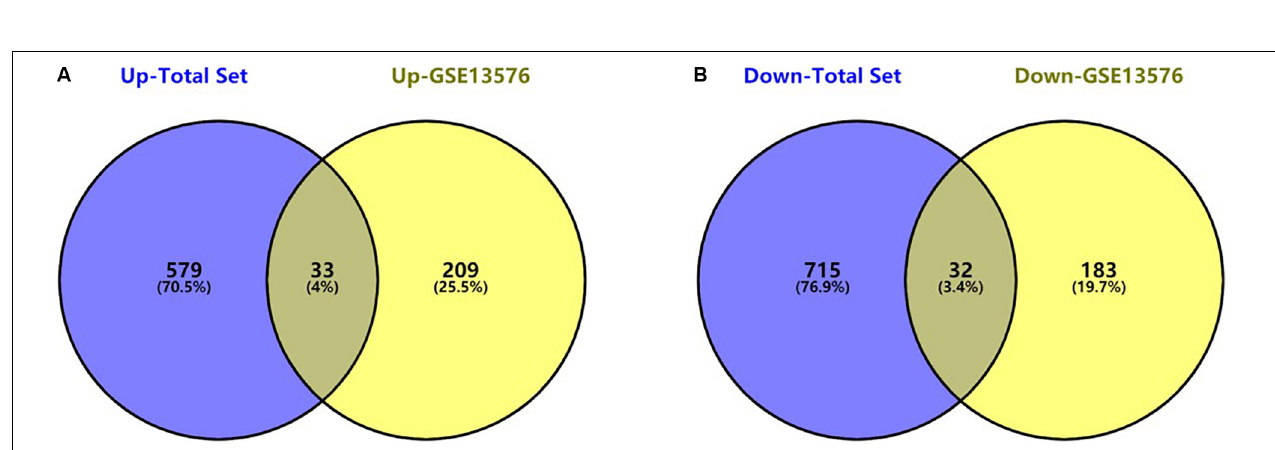
FIGURE 3 | Commonly changed DEGs in Total Set and GSE13576. (A) Upregulated genes in two datasets (33 common DEGs) (B) Downregulated genes in two datasets (32 common DEGs).